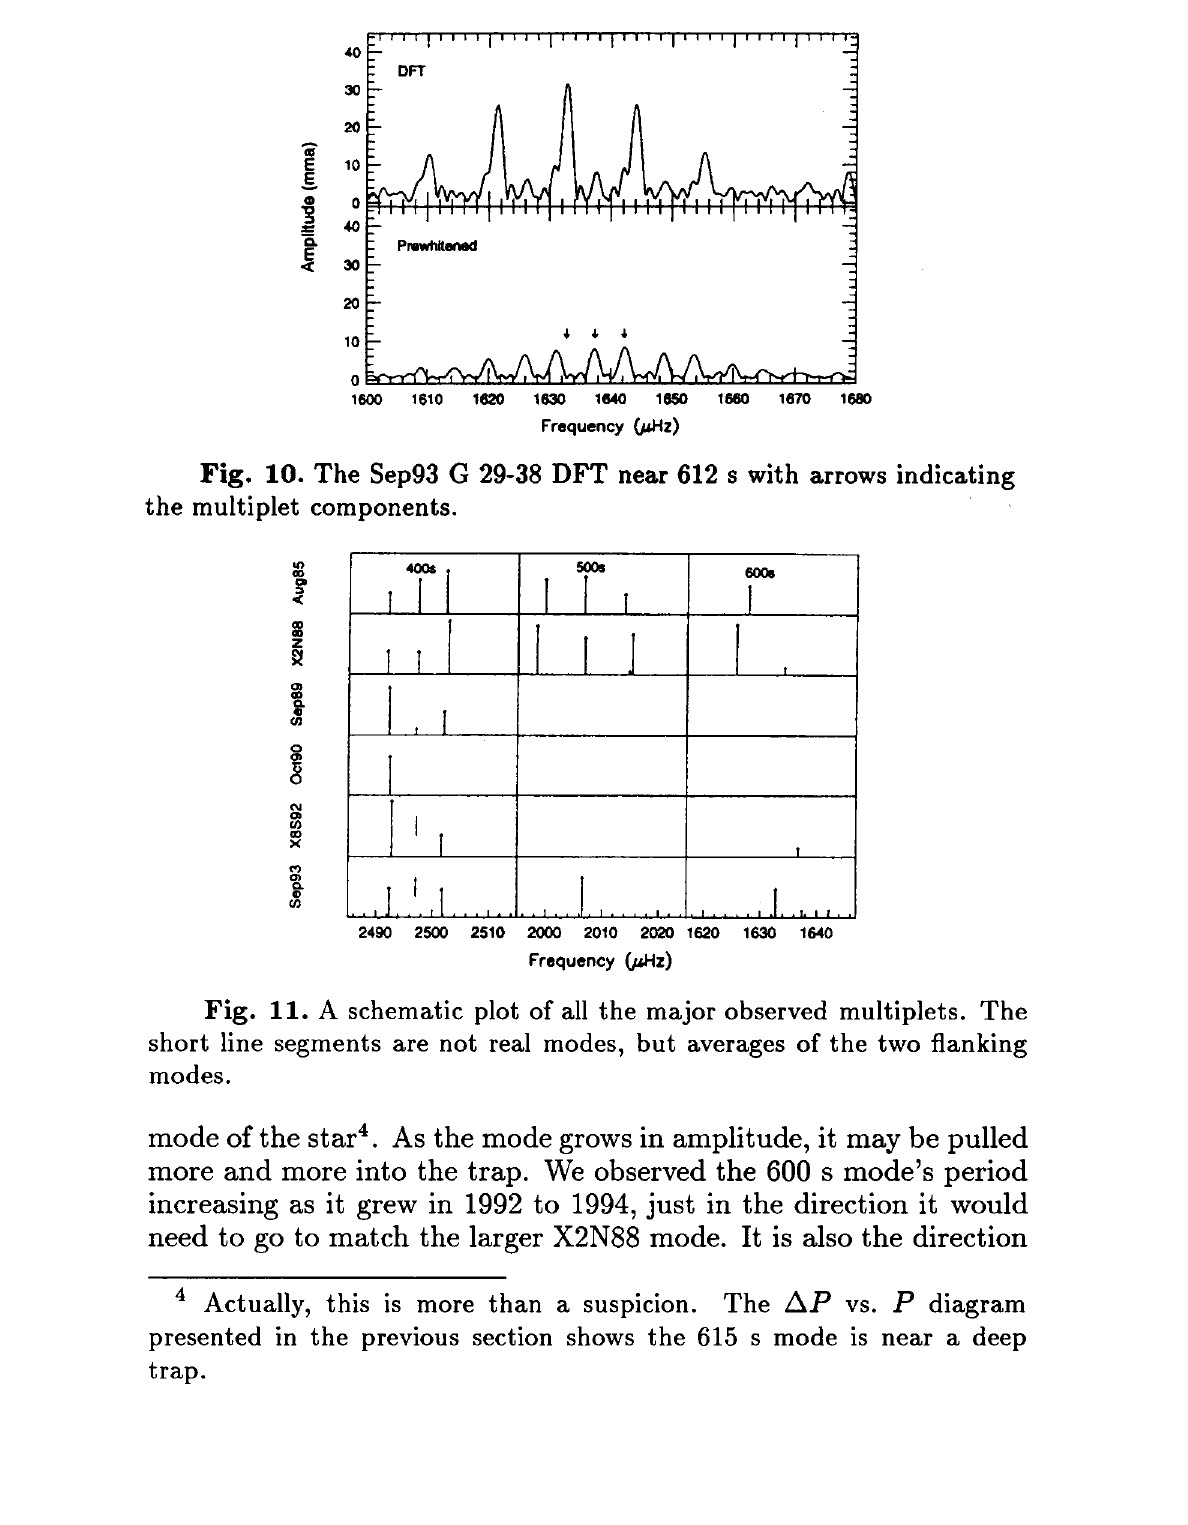
Fig. 10. The Sep93 G 29-38 DFT near 612 s with arrows indicating the multiplet components.